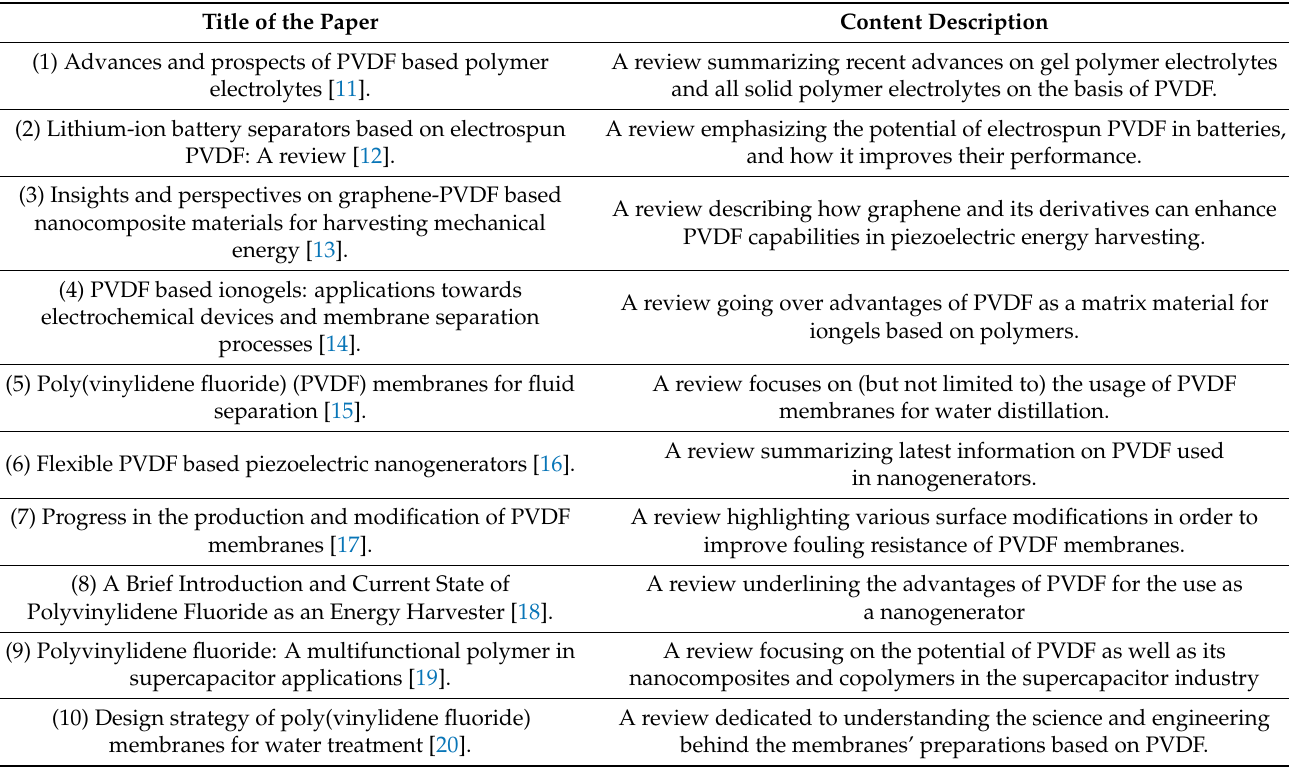
Table 1. A list of published review papers on PVDF and short descriptions of their